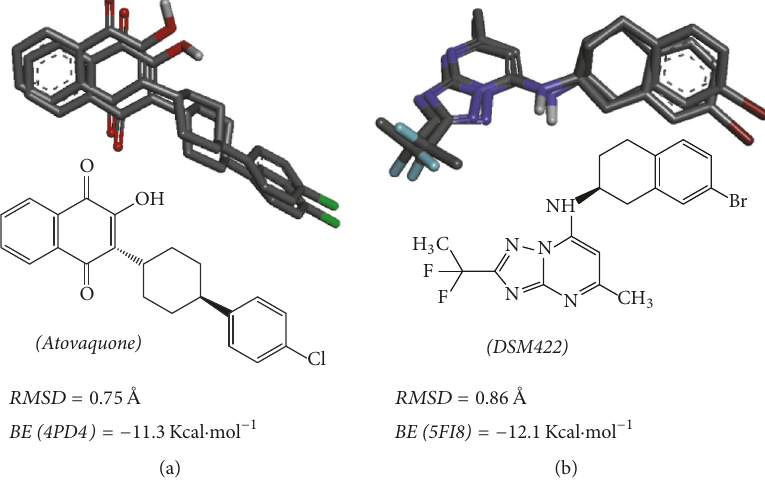
Figure 3: Values of the root mean square deviation (RMSD) of redocking and binding energy (BE) for the interaction of 4PD4 with atovaquone (a) and of 5FI8 with DSM422